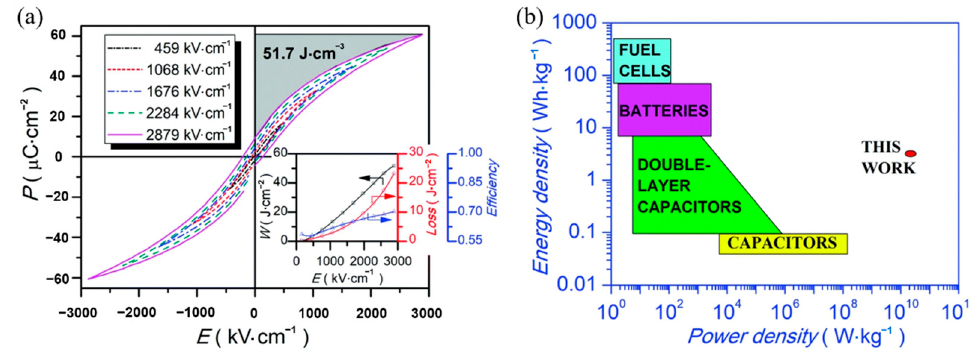
Figure 21. Energy density and power density measurements of the BCT–BMT thin film. ( a ) P–E loops. Inset: W energy , W loss and Z versus E. ( b ) Energy density & power density diagram. Reprinted with permission from [92]. Copyright 2019 The Royal Society of Chemistry.